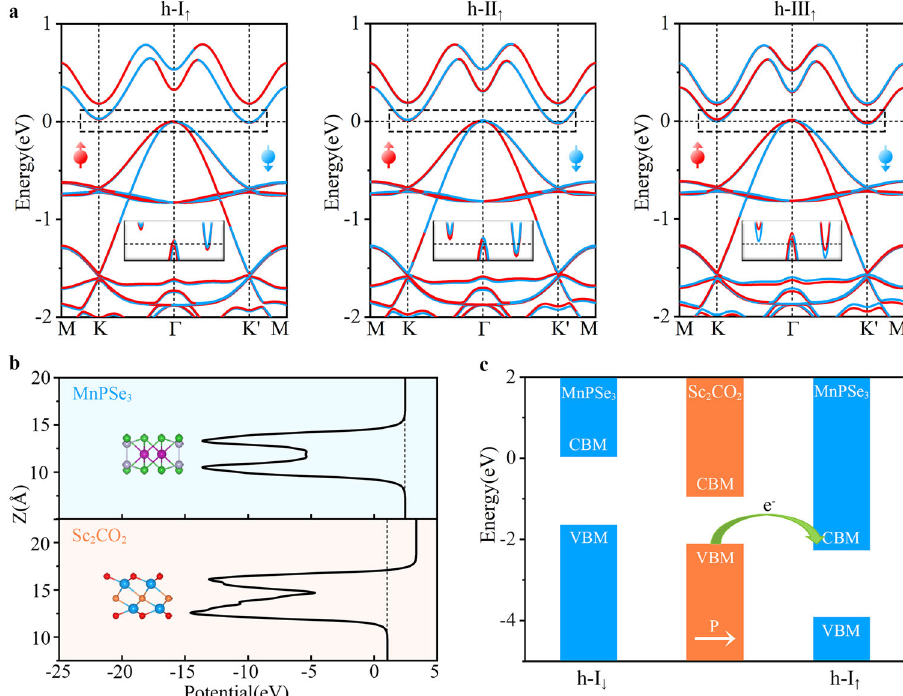
Fig. 4 Ferroelectric-polarization-dependent properties in MnPSe 3 /Sc 2 CO 2 . Band structures of h-I ↑ , h-II ↑ and h-III ↑ with considering SOC. Blue and red lines in a correspond to spin-down and spin-up states, respectively. The Fermi level is set to 0 eV. b Plane-averaged electrostatic potentials of monolayer MnPSe 3 and Sc 2 CO 2 along the z direction. c Band alignments of h-I ↓ and h-I ↑ with respect to the vacuum